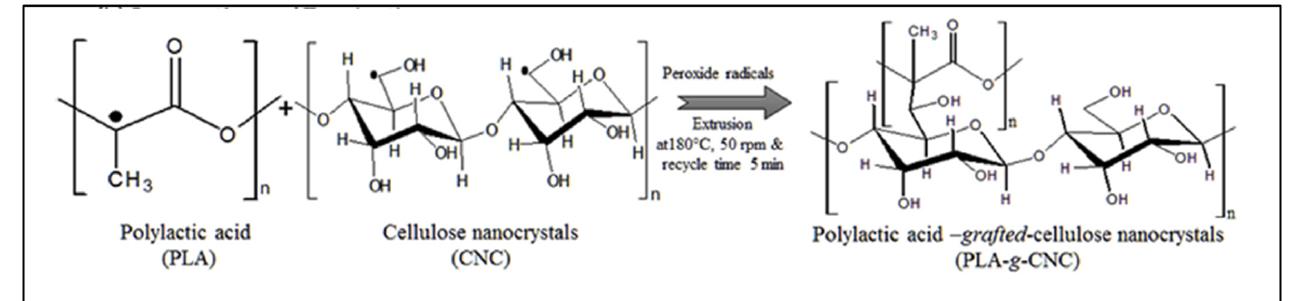
Figure 9. Reaction scheme for the synthesis of PLA- g -CNC (from Dhar et al. [43], copyright Elsevier, reproduced with permission).